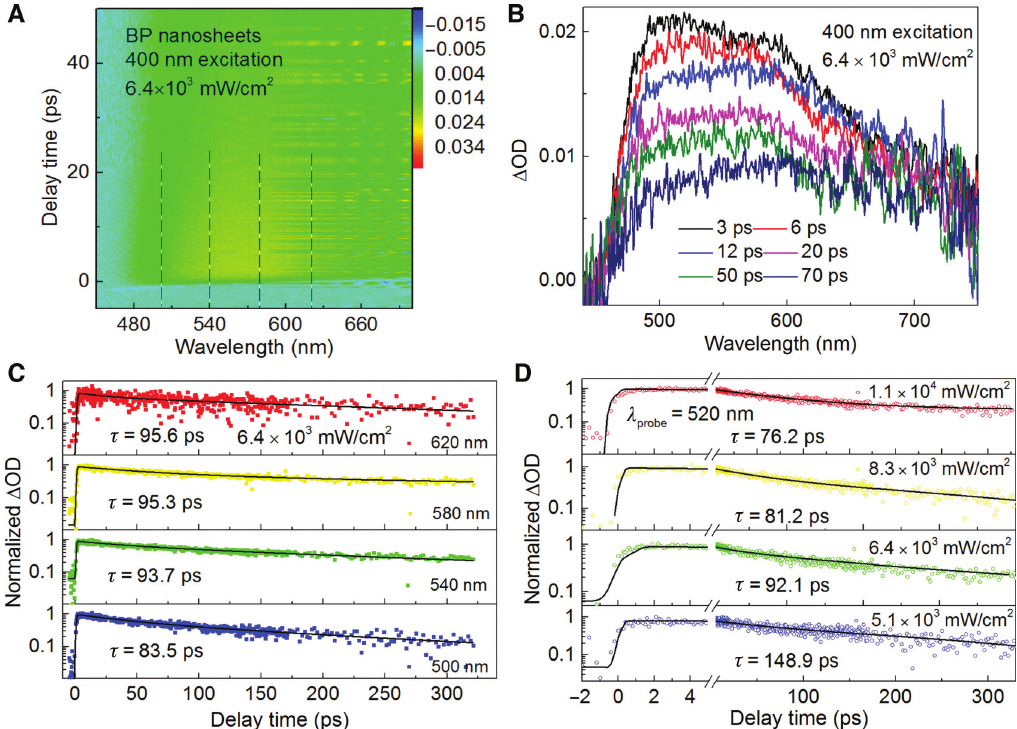
Figure 2: Wavelength and fluence dependent (low fluence region) ultrafast carrier dynamics of BP nanosheets with pump wavelength at 400 nm. (A) Two-dimensional (2D) mapping of transient absorption (TA) spectra for black phosphorus (BP) nanosheets pumped at 400 nm with a fluence of 6.4 × 10 3 mW/cm 2 . (B) Spectra of change of optical density at different delay times. (C) Carrier dynamics (at 400 nm pump) at different probe wavelengths with pump fluence fixed at 6.4 × 10 3 mW/cm 2 . (D) Carrier dynamics (at 400 nm pump) at different pump fluences from 5.1 × 10 3 mW/cm 2 to 1.1 × 10 4 mW/cm 2 with a probe wavelength fixed at 520